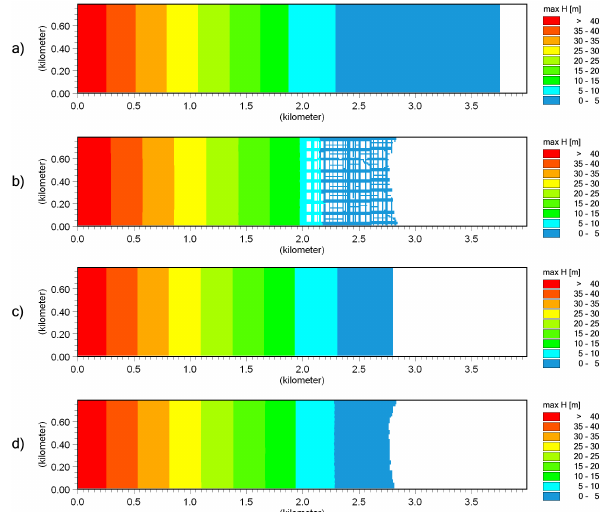
Fig. 4. Inundations (max. water depths): (a) No city. (b) Houses are non-calculation cells. (c) Unknown distribution of houses, Manning value of M =7.7m 1 / 3 /s on the land side. (d) Houses are substituted by roughness elements with a Manning value of M =2.5m 1 / 3